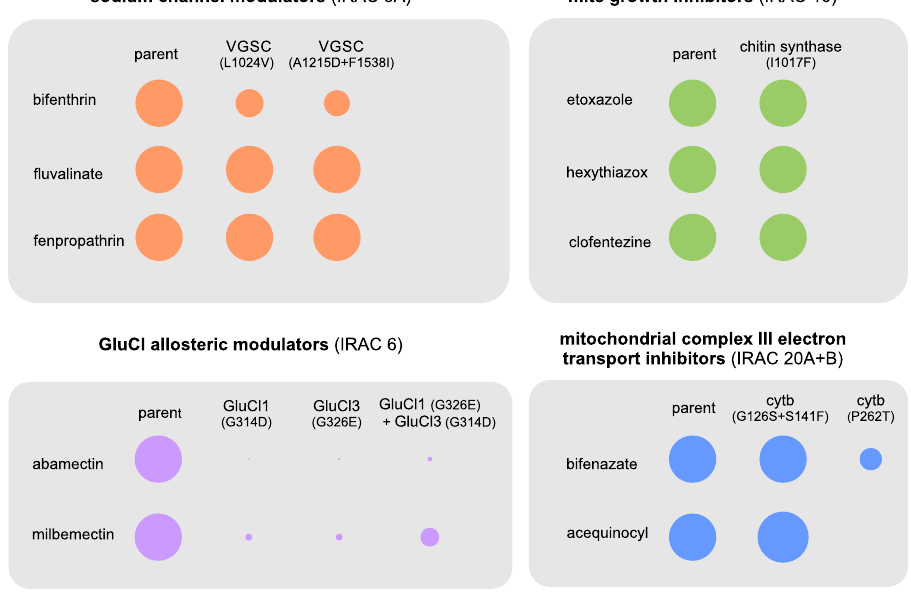
Figure 5. Schematic representation of the relative contribution of target site resistance mutations in overall resistance levels to acaricides belonging to different mode of action groups. The size of the circle shape reflects the observed levels of resistance (RR vs susceptible parent strain). Only comparisons between the backcrossed lines versus its resistant parent are drawn to scale (Table